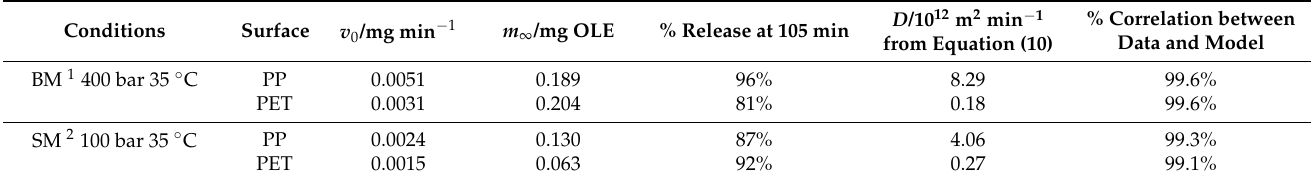
Table 4. First-order rate constants and total mass transfer of OLE in a 50% ethanol food simulant.